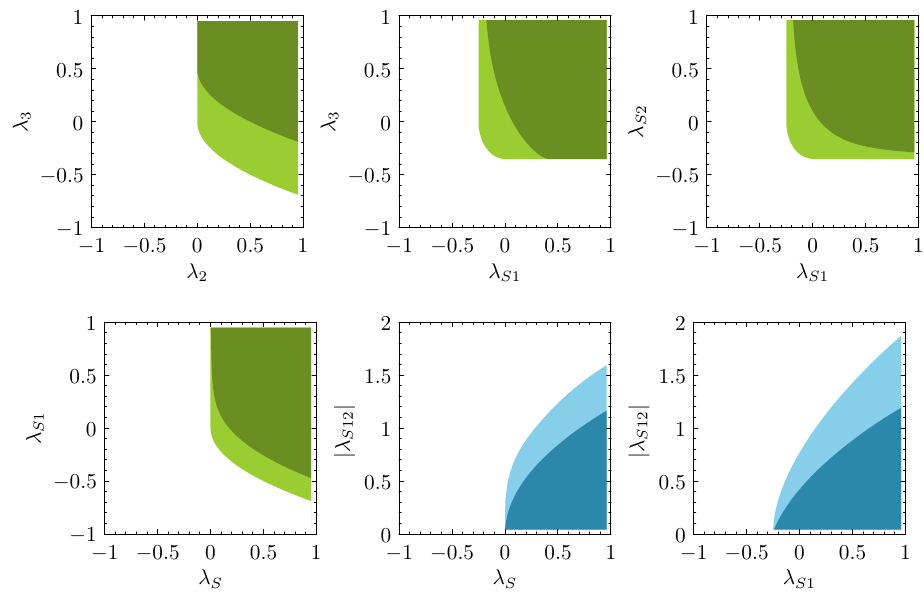
Fig. 5 Anexampleofparameterspaceallowedbythevacuumstability allowed for for | λ S 12 | = 0, while | λ S 12 | = 0 . 5 only allows the dark green region . In the last two panels, where | λ S 12 | varies, only the dark conditions (108) for the potential (89) of the SM Higgs, an inert dou- blue region is allowed for λ S 2 = 0, while λ S 2 = 0 . 5 allows both the blet and a complex singlet. The values of parameters are λ H = 0 . 125, λ = 0 . 125, λ = 0 . 25, λ = λ = λ = λ = 0, except for dark and light blue S S 1 S 2 2 3 4 plots where these couplings vary. Both light and dark green regions are